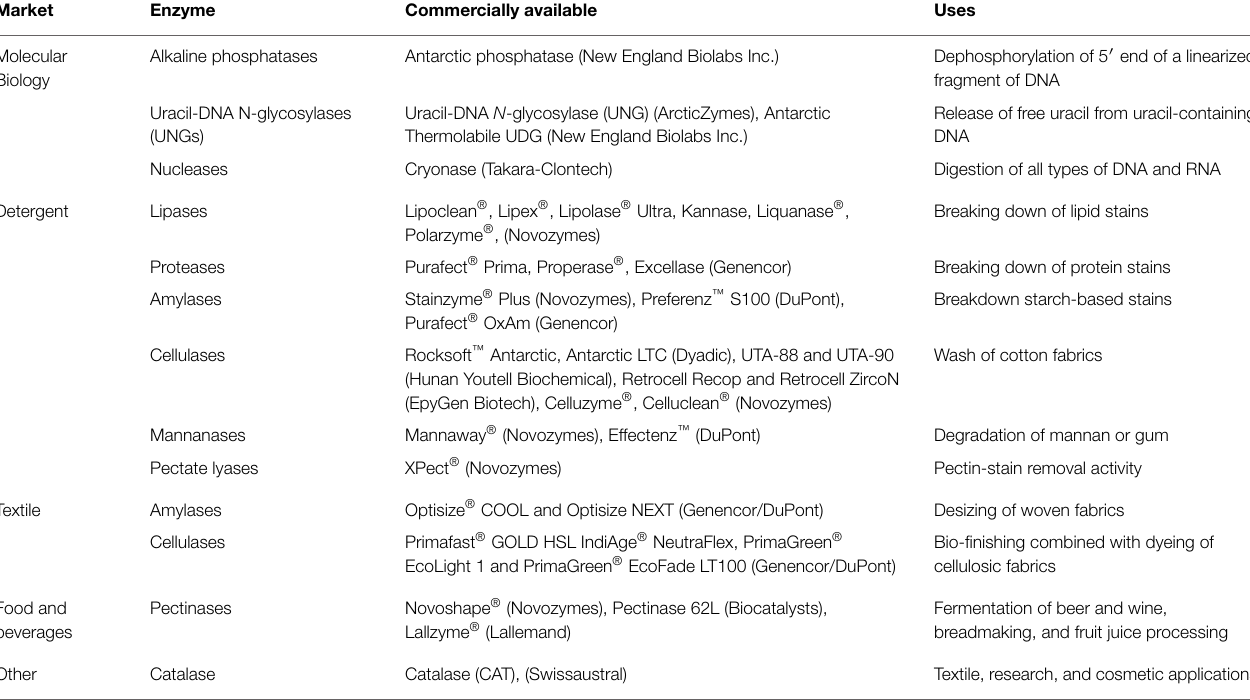
TABLE 1 | Examples of commercially available cold-active enzymes .